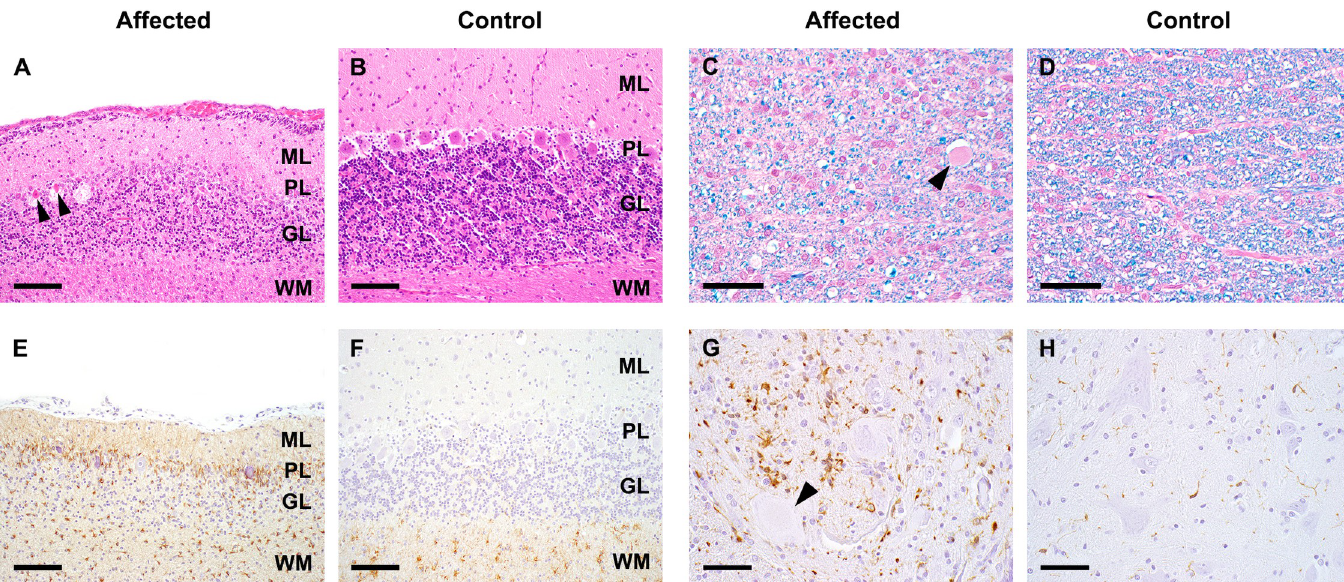
Fig 2. Histopathological examination. A, B Cerebellum: Marked attenuation of all cortical layers and necrotic Purkinje cells (arrowheads) ( A ) compared to control ( B ). ML: molecular layer, PL: Purkinje cell layer, GL: granule cell layer, WM: white matter; HE-staining, bar = 100 μ m. C, D Spinal cord white matter: Diminished myelination (blue staining) and axonal degeneration (arrowhead) ( C ) compared to control ( D ); HE-LFB staining, bar = 50 μ m. E, F Cerebellum: Increased numbers and activation of astrocytes particularly in Purkinje cell and granule cell layer ( E ) compared to control ( F ); GFAP-IHC, bar = 100 μ m. G, H Spinal cord gray matter: Increased numbers and activation of microglia associated with neuronal degeneration (arrowhead) ( G ) compared to control ( H ); Iba1-IHC, bar = 50 μ m.